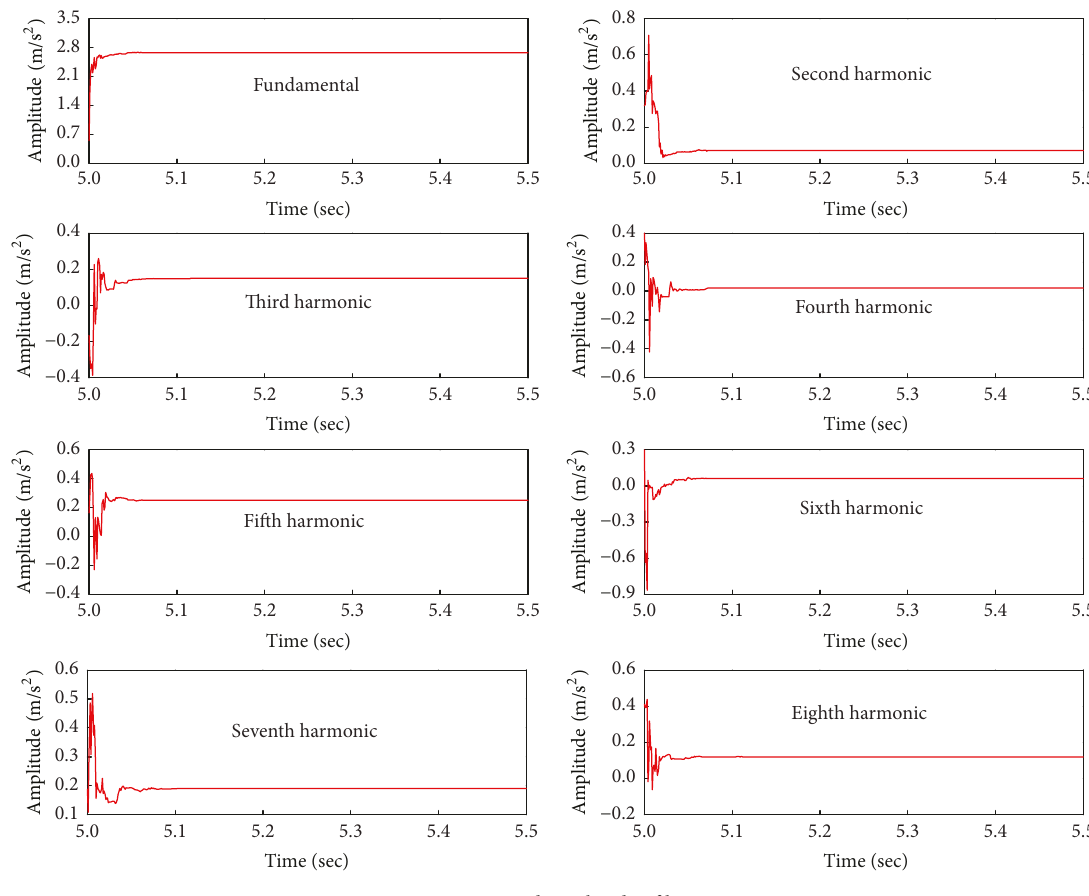
Figure 10: Estimated amplitude of